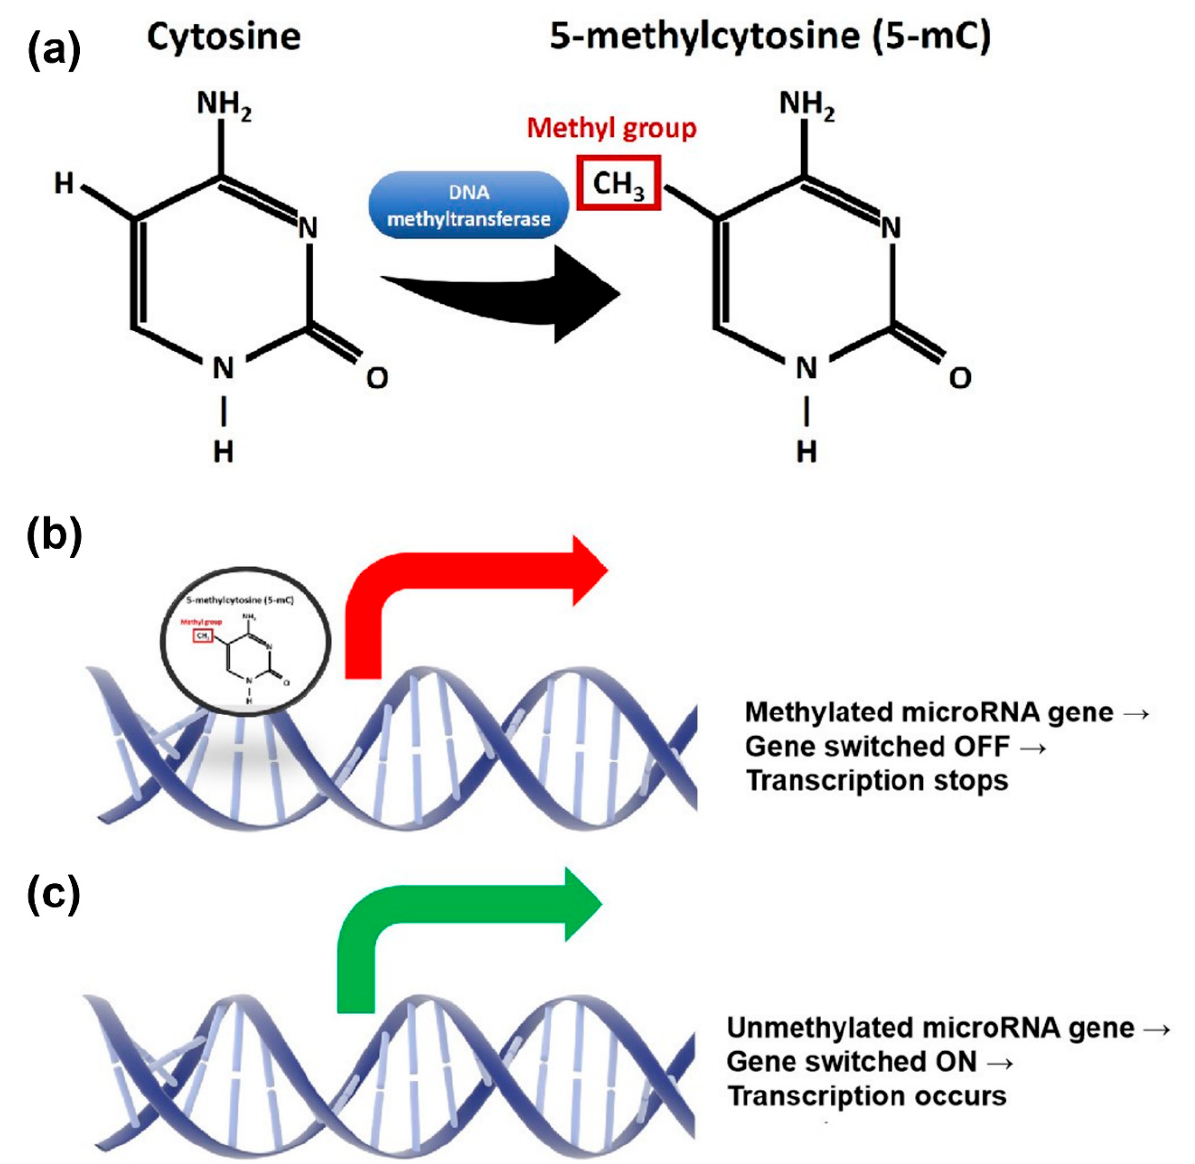
Figure 1. Overview of the methylation process. ( a ) Methylation is defined as an addition of a methyl group to the cytosine ring. ( b ) When the microRNA gene is methylated, it will be switched off and the transcription process will stop. No mature microRNA will be expressed. ( c ) When there is absence of methylation, the microRNA gene will be switched on, therefore transcription will occur and mature microRNA will be expressed.